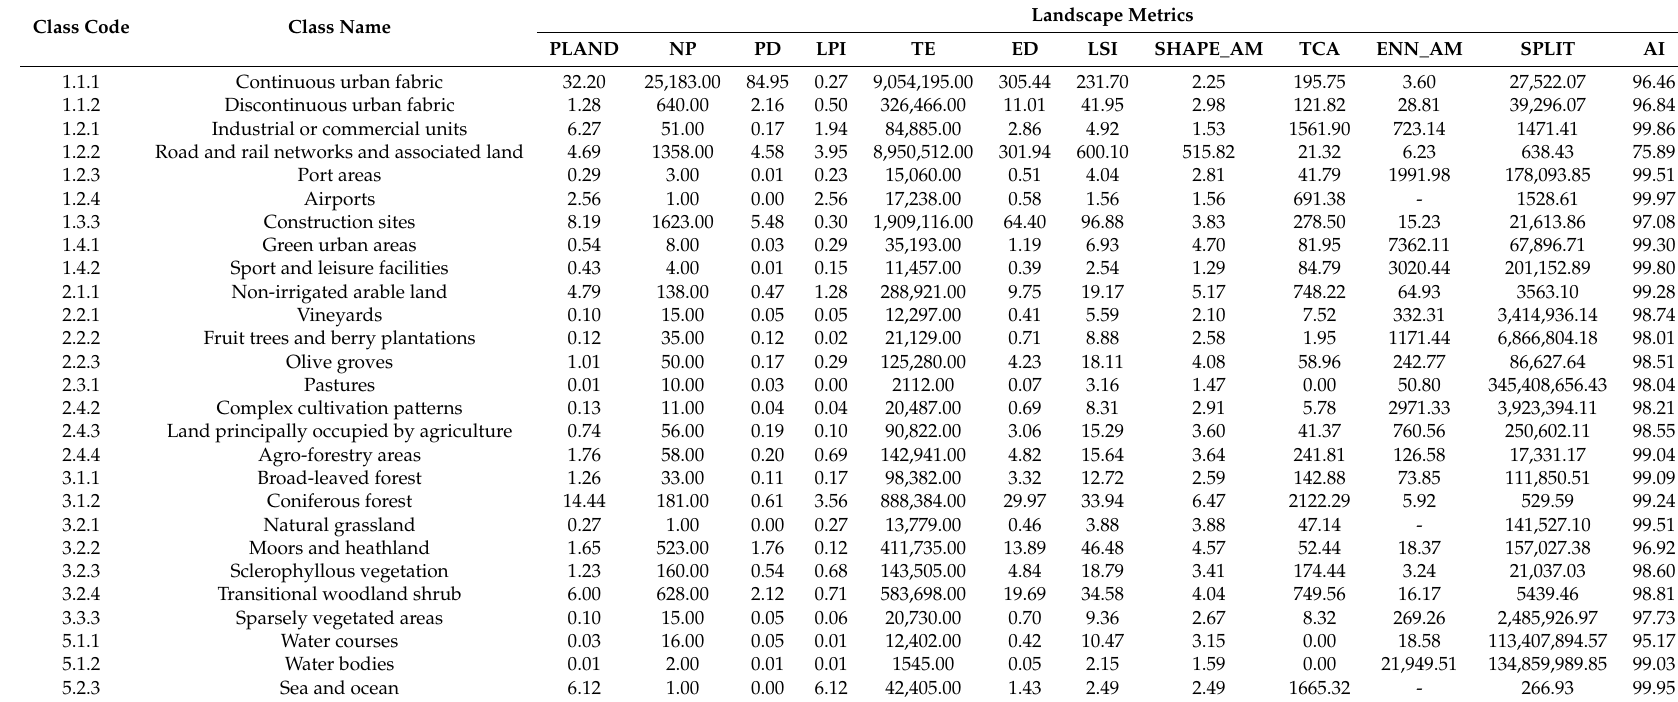
Table 9. Level 3 landscape metrics